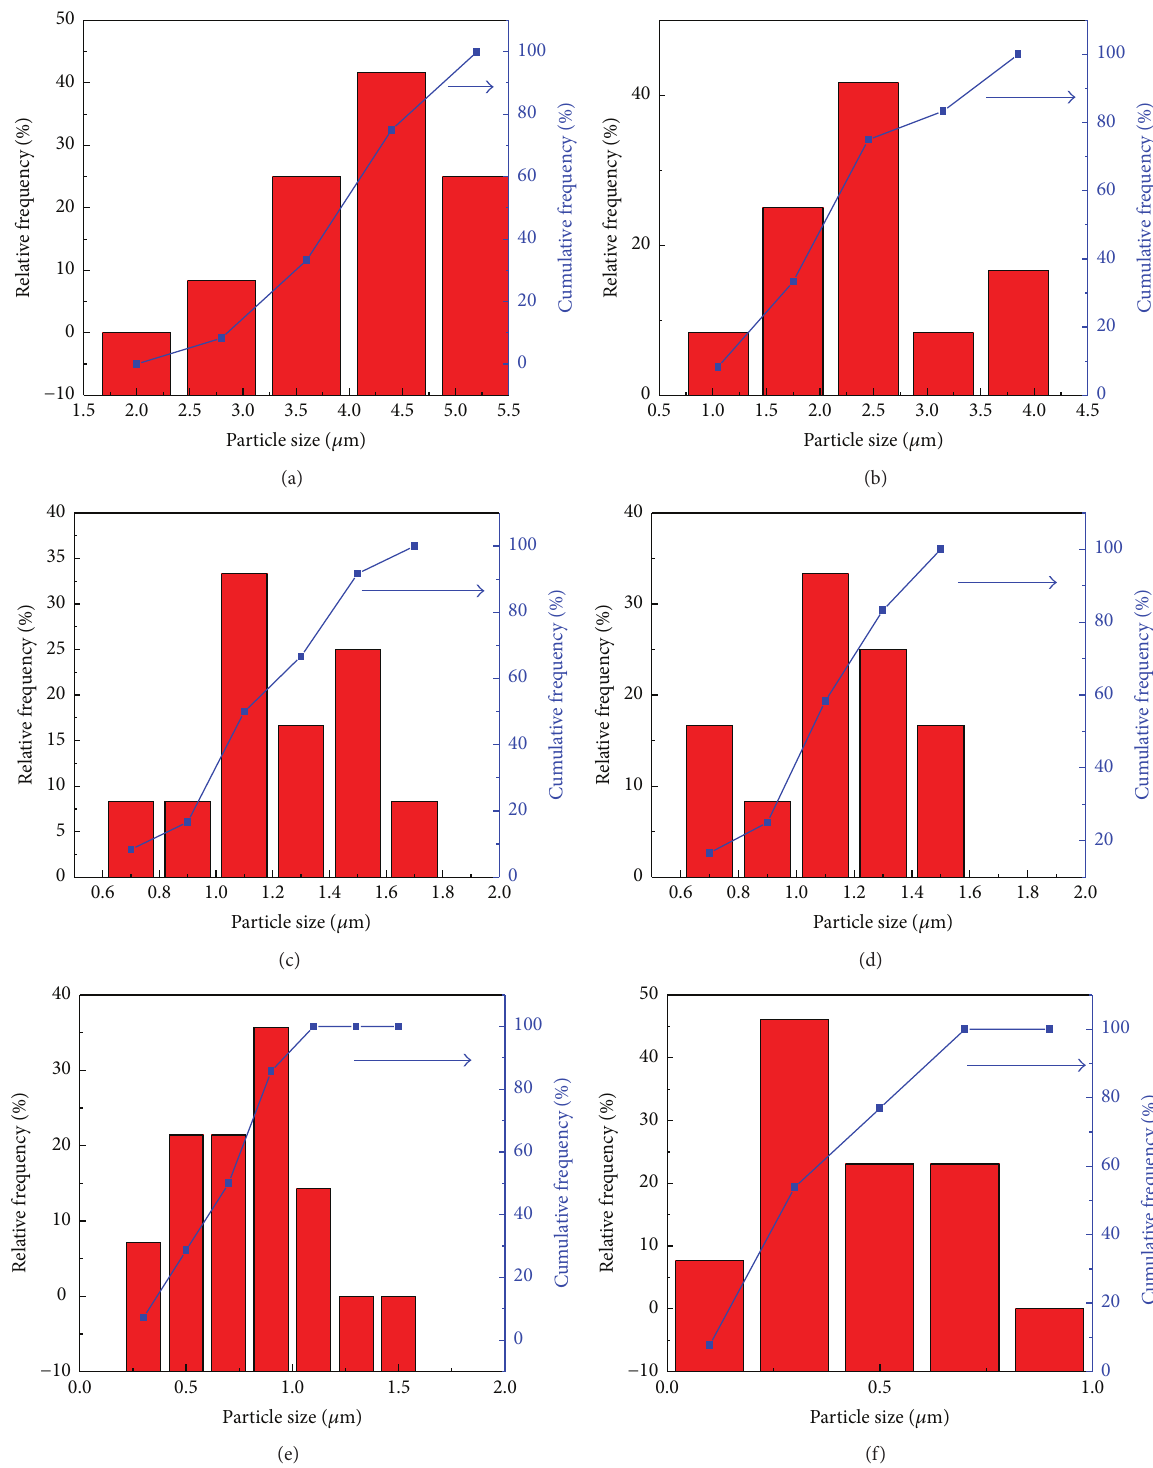
Figure 3: Particle size distribution of products obtained by combustion synthesis with different contents of diluter. (a) 0% NaCl; (b) 10 wt% NaCl; (c) 20wt% NaCl; (d) 30 wt% NaCl; (e) 40 wt% NaCl; (f) 50 wt%